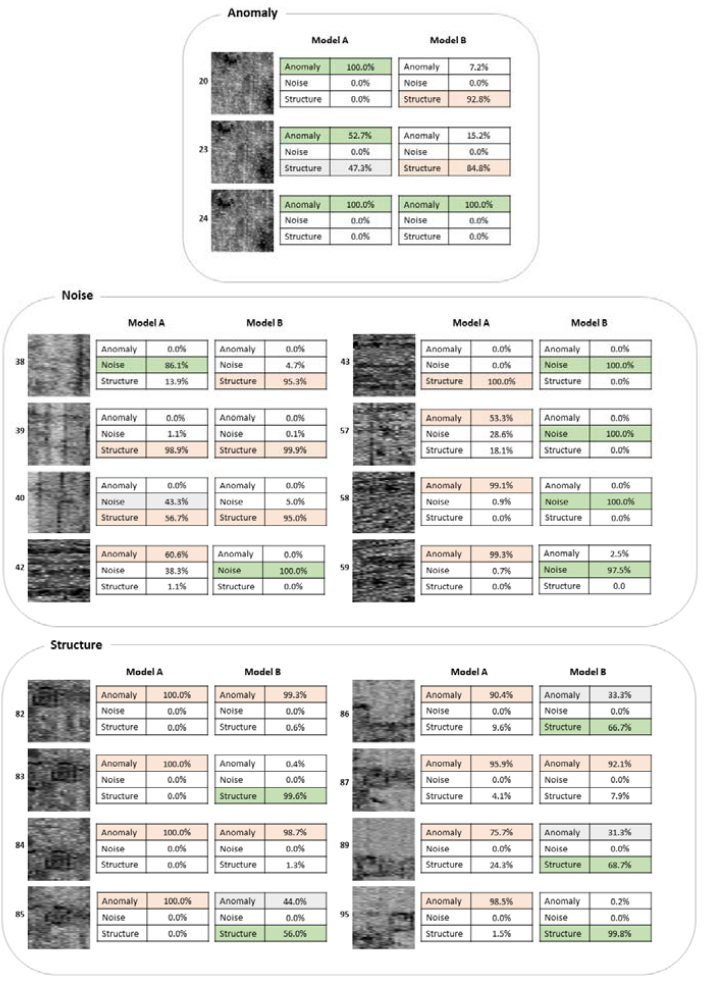
Figure 5. Examples of the evaluation set for which incorrect predictions were made either by Model A, Model B, or both. Green color indicates the correct predictions; yellow, the incorrect predictions, while gray tones indicate the second higher classification percentage of a class.